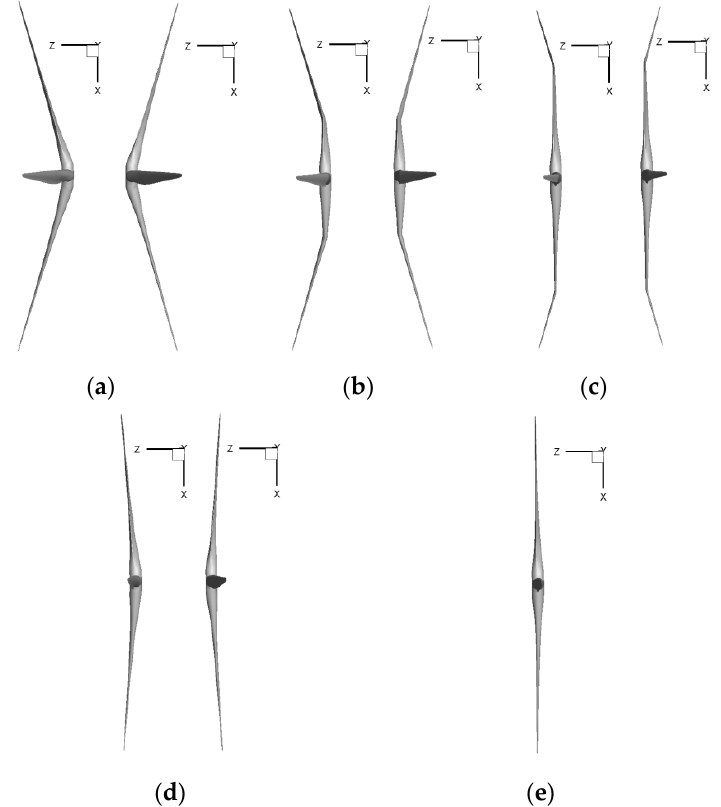
Figure 3. Shapes of coning configurations: ( a ) C cone = ± 4 and T trans = 5 / R , ( b ) C cone = ± 4 and T trans = 1 / 3; ( c ) C cone = ± 4 and T trans = 2 / 3; ( d ) C cone = ± 16 and T trans = 1 / 3; ( e ) straight.